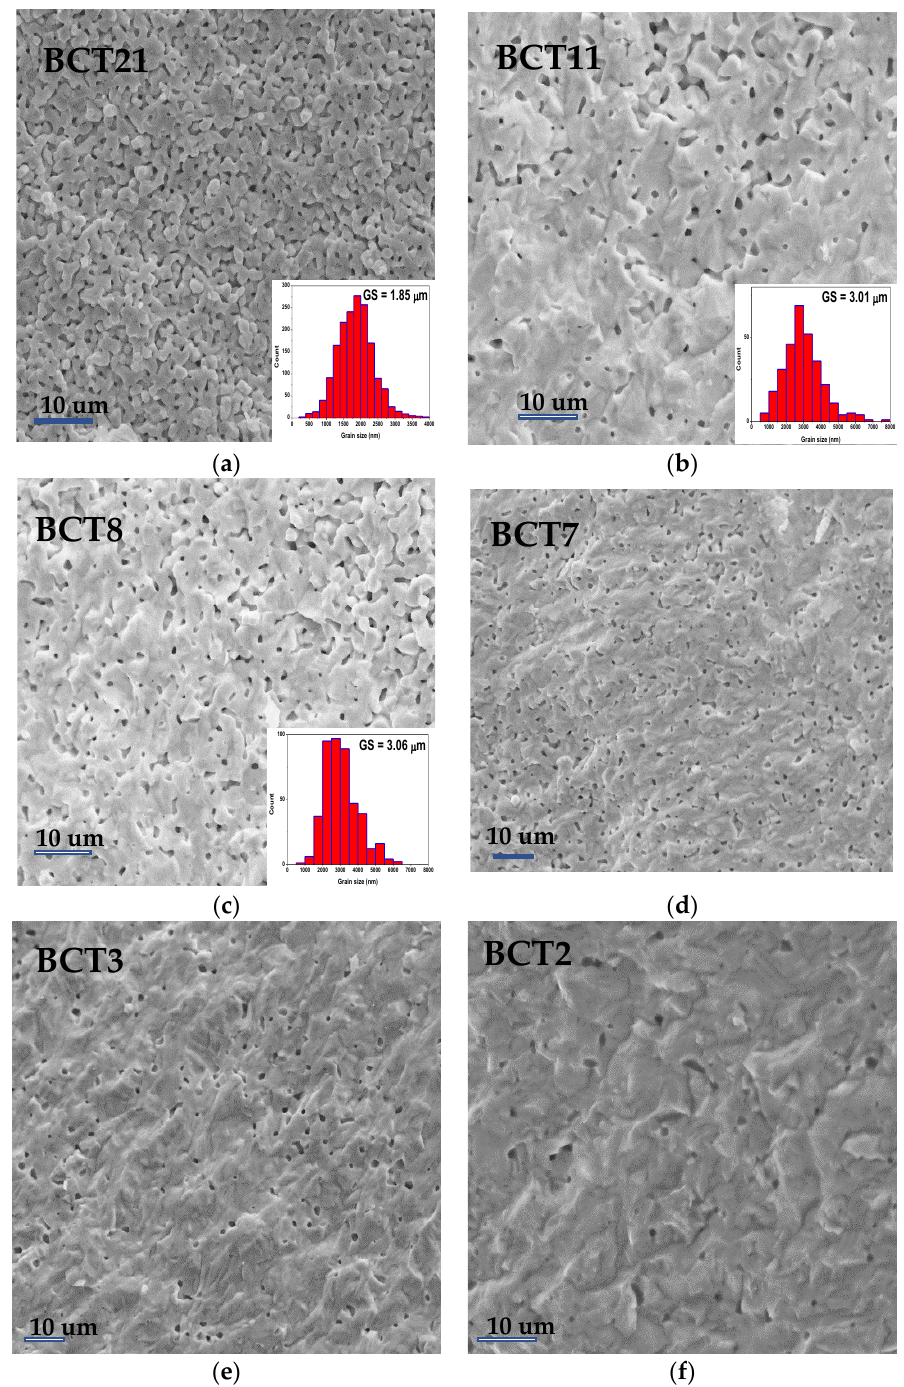
Figure 2. SEM images of Ba 0.90 Ca 0.10 TiO 3 ceramics with different porosity levels and grain size: ( a ) 21% porosity; ( b ) 11% porosity; ( c ) 8% porosity; ( d ) 7% porosity; ( e ) 3% porosity; ( f ) 2% porosity.